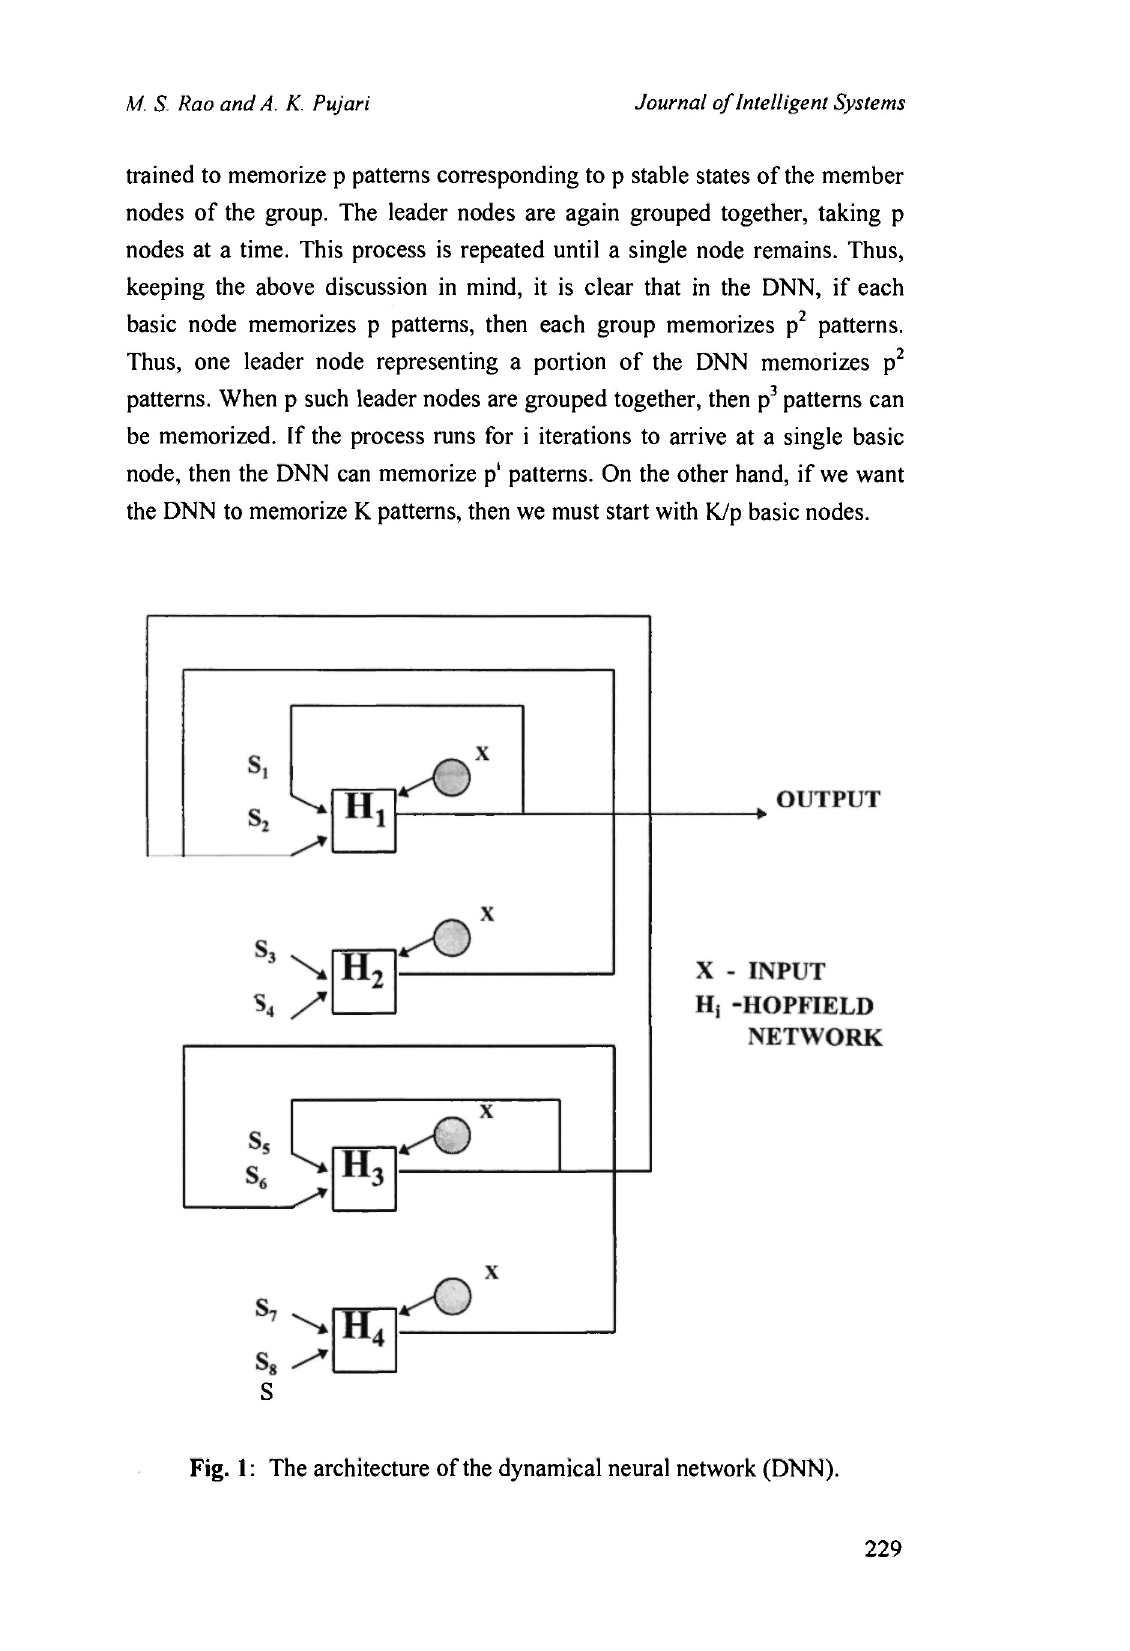
Fig. 1: The architecture of the dynamical neural network